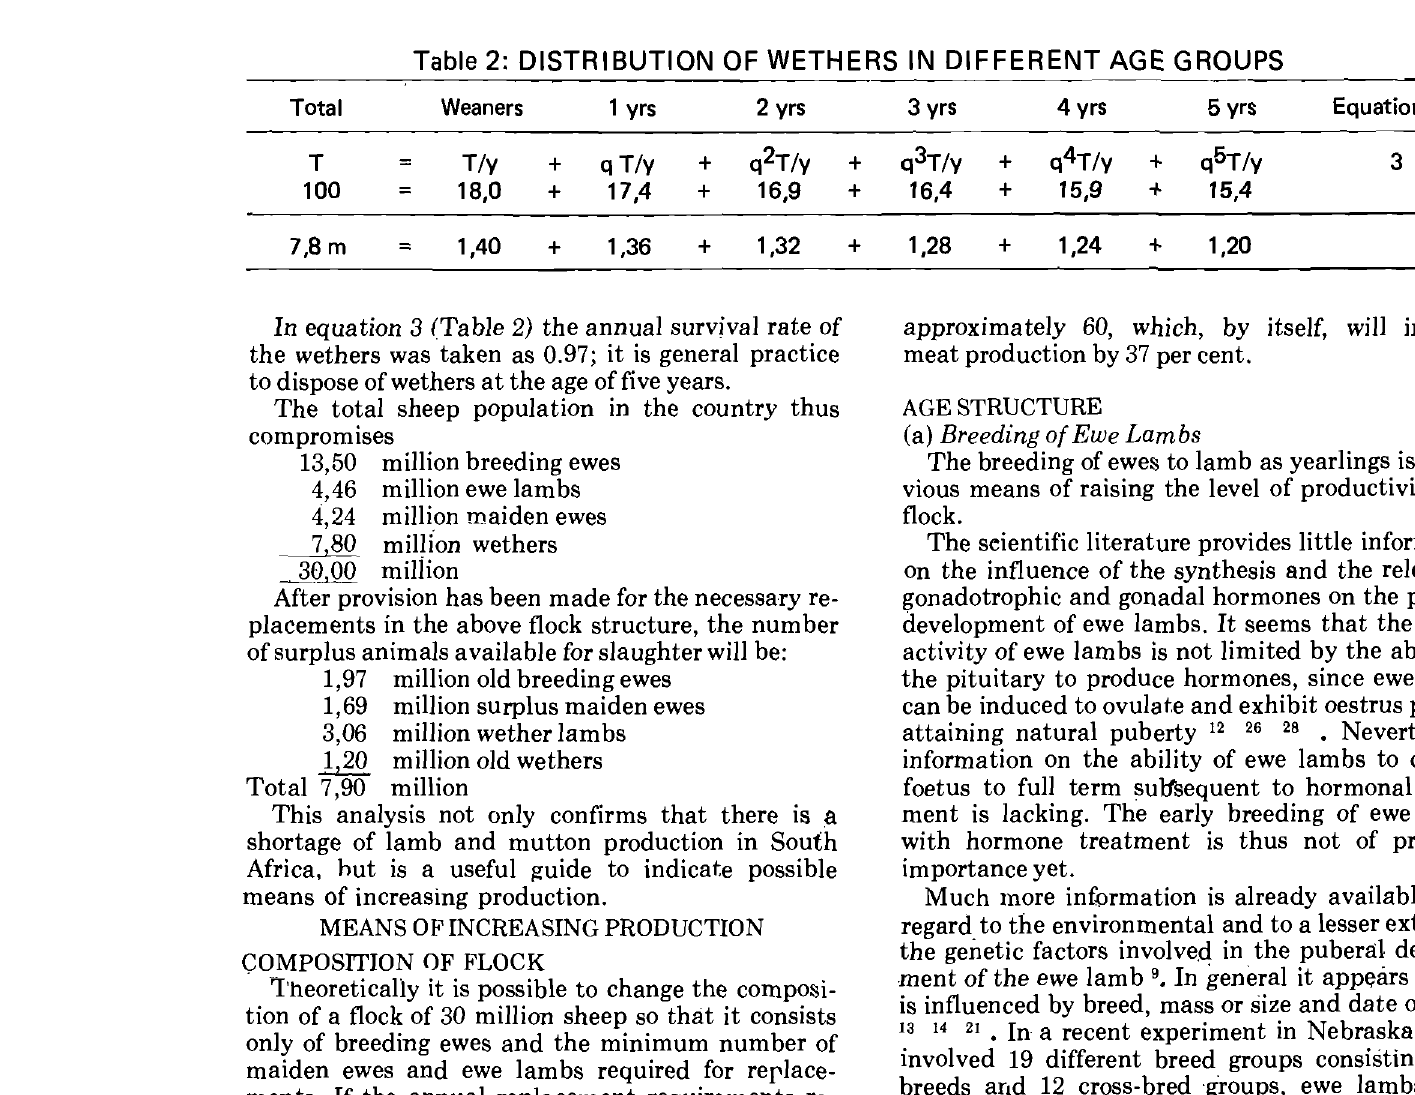
Table 3: COMPOSITION OF AN IDEAL FLOCK CONTAINING THE MAXIMUM NUMBER OF BREEDING